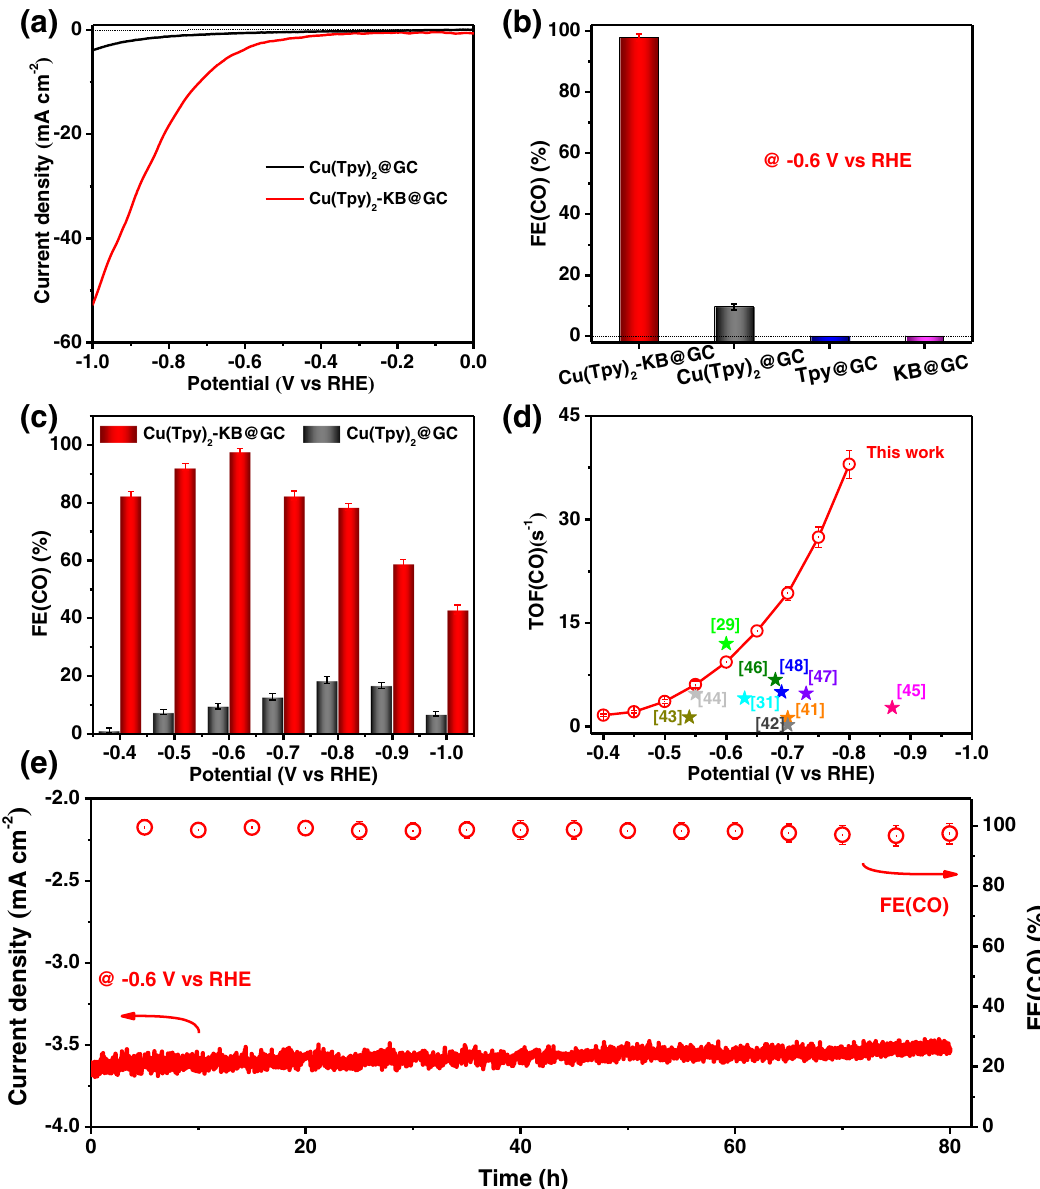
Fig. 2 | CO2RR performance of Cu(Tpy)2@GC and Cu(Tpy)2-KB@GC electro- catalysts. a Linear sweep voltammetry of neat Cu(Tpy) 2 @GC and Cu(Tpy) 2 - KB@GC in a CO 2 -saturated 0.5M KHCO 3 electrolyte. b FEs for CO and H 2 pro- ductionofneatKB@GC,Tpy@GC,Cu(Tpy) 2 @GCandCu(Tpy) 2 -KB@GC. c FE(CO)s of Cu(Tpy) 2 @GC and Cu(Tpy) 2 -KB@GC at different applied potentials. d TOFs